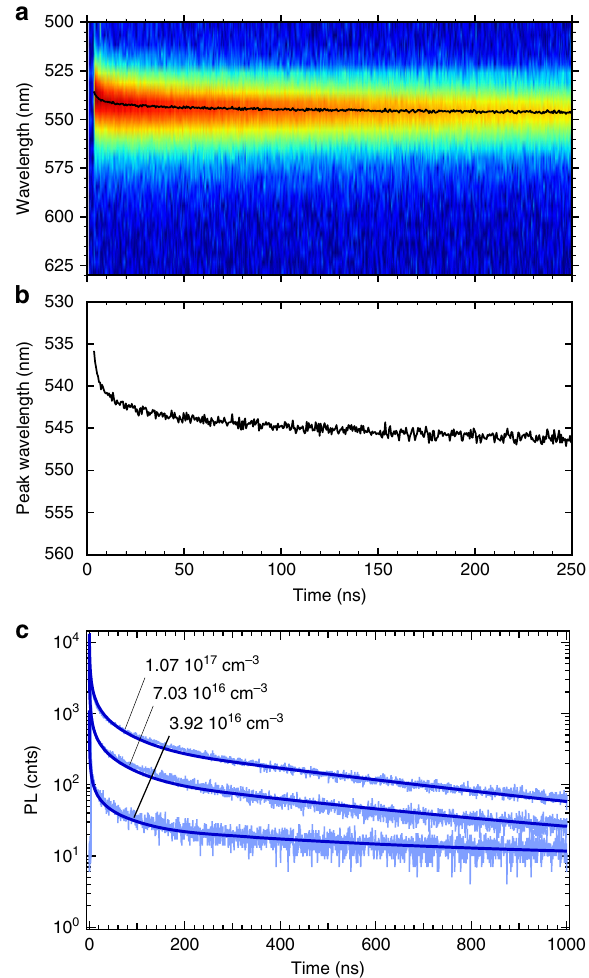
Fig. 5 Time-resolved photoluminescence spectra of CH 3 NH 3 PbBr 3 single crystals. a 2D spectral map, b shift of the peak centre position with time. c Numerical evaluation of Eq. (2) for three decays extracted from Supplementary Fig. 7. The initial carrier densities are indicated on the Figure. Parameters: µ n = 10 cm 2 V − 1 s − 1 , µ p = 50 cm 2 V − 1 s − 1 , k 2 = 1×10 −